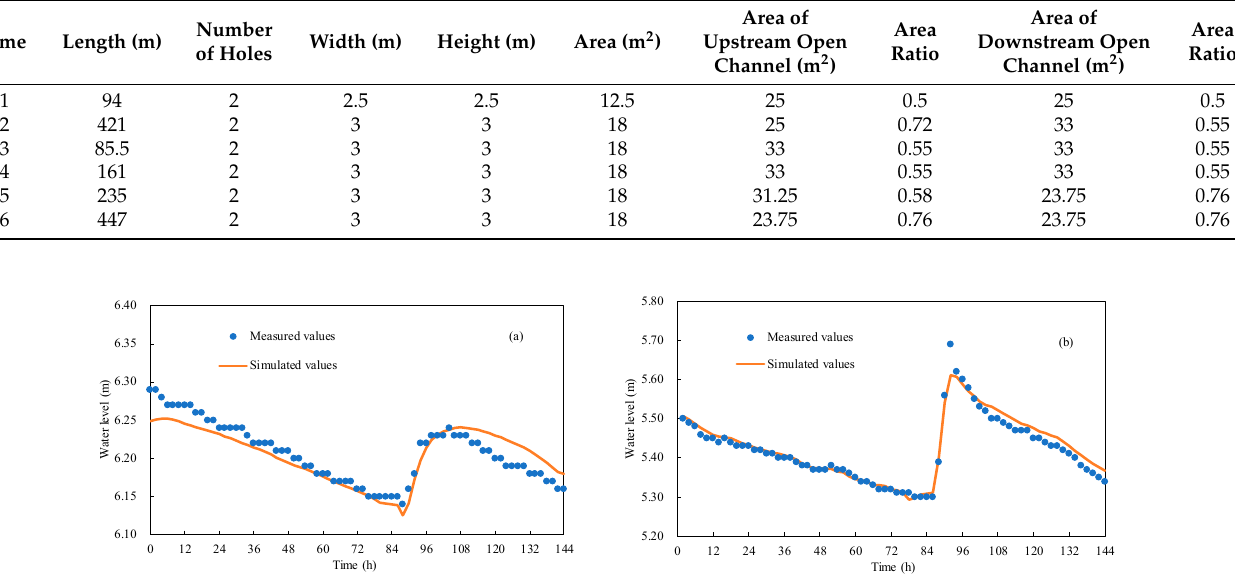
Table 1. The parameters of inverted siphons.